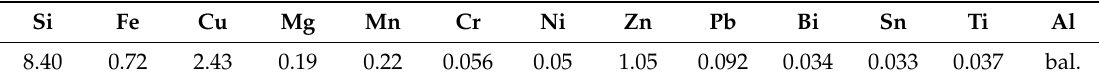
Table 1. Composition (wt.%) of the AlSi9Cu3(Fe) base alloy.